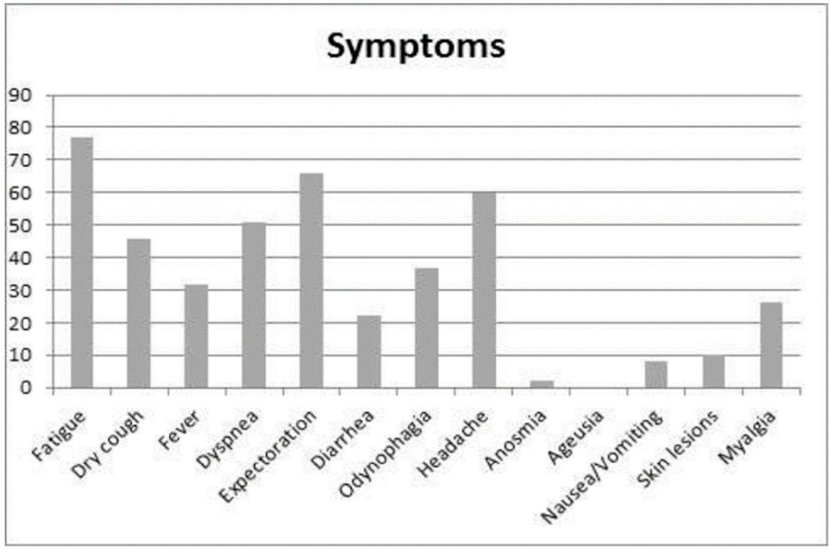
Figure 4. Symptoms most frequently reported by